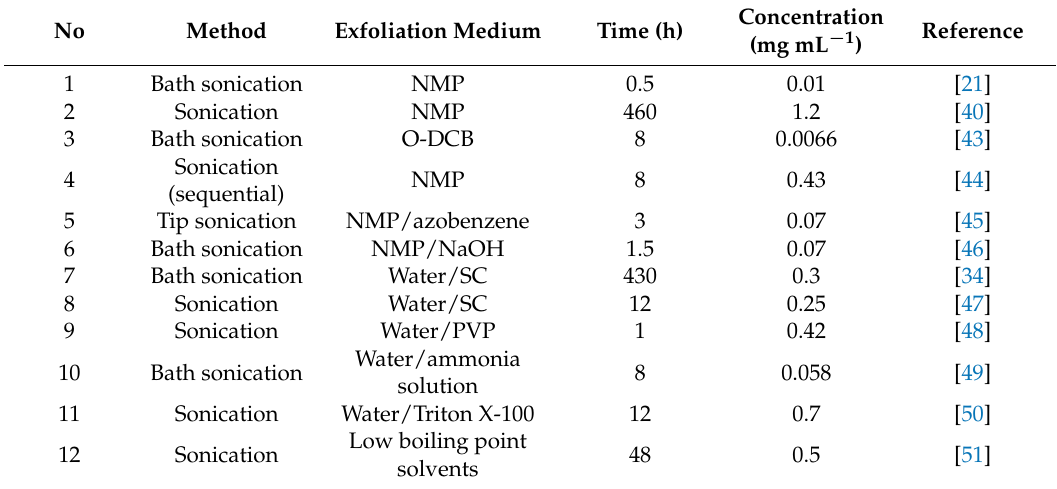
Table 2. Concentration of graphene produced via sonication in relation to exfoliation time and